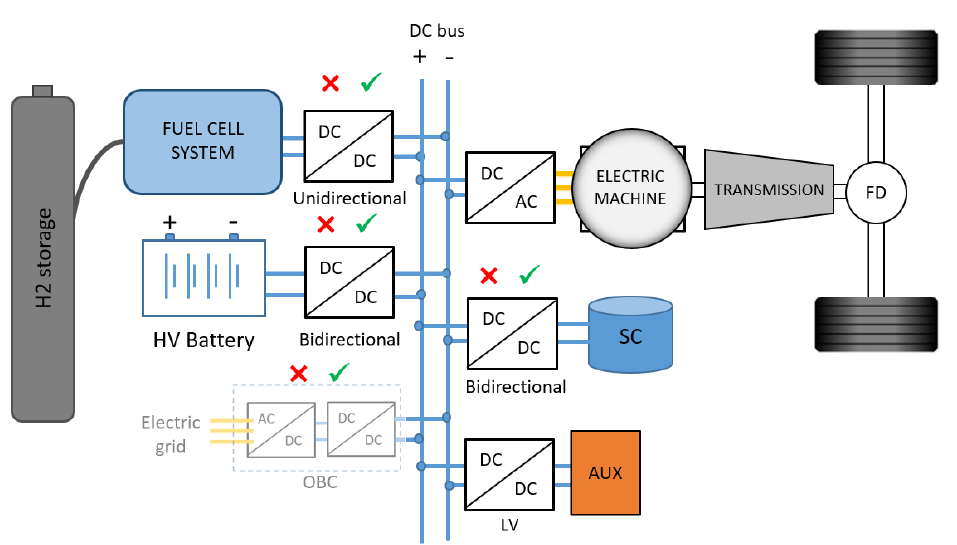
Figure 1. Generic fuel cell electric vehicle (FCEV) powertrain topology including fuel cell system (FCS), HV battery, electric drive, supercapacitor (SC), transmission, LV auxiliary loads, onboard charger and related power electronics